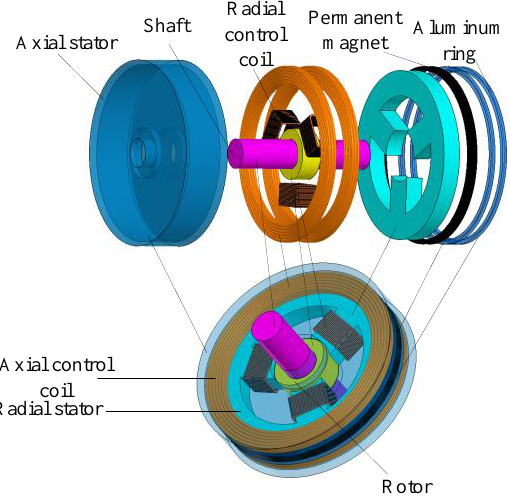
Figure 3. Configuration of AC-DC 3-DOF HMB.